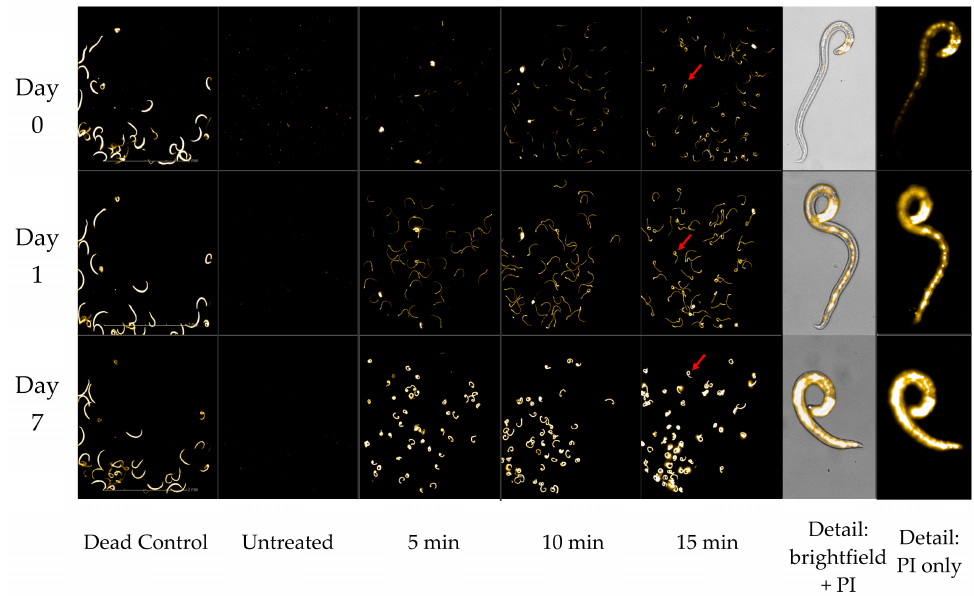
Figure 2. Visual comparison of L3 fluorescence by day to ozone treatment with the Cashido using di- rect gas delivery. Each row illustrates uniformity of fluorescence in response to ozone for durations of 5, 10, and 15 min (in triplicate), along with a close-up of specific L3 (red arrow) after 15 min